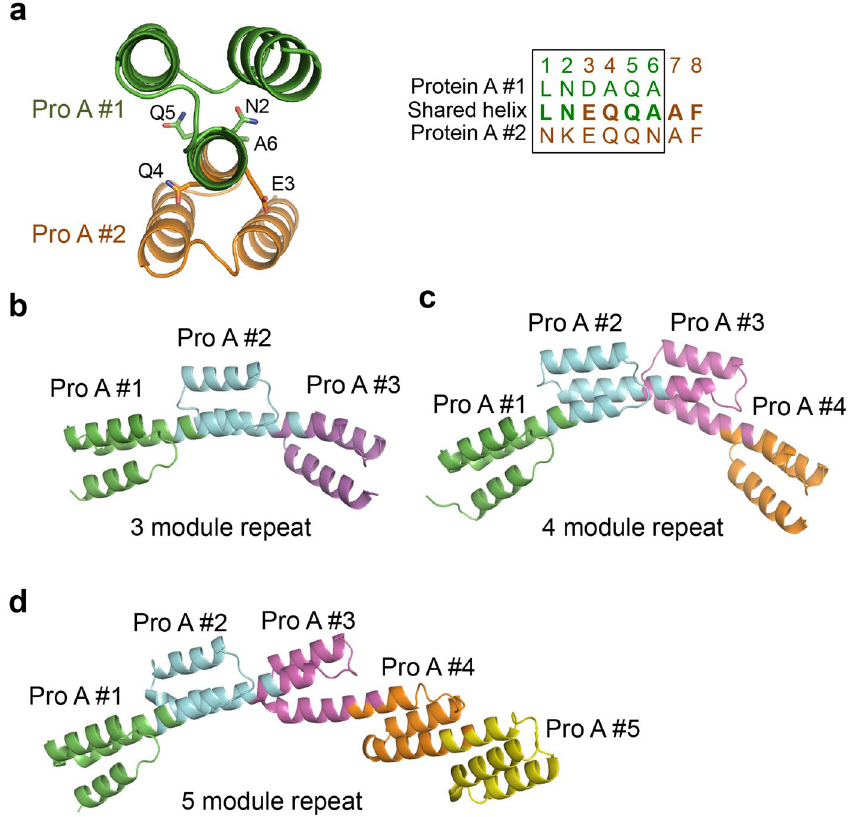
Figure 5. Construction of a repeat protein using the protein A domain as the repeat module. ( a ) Fusion strategy of protein A domains by the shared helix method. The amino acid sequences of the shared helix are shown on the right. The side chains of amino acids in the shared region are drawn as sticks. ( b ) The crystal structure of a repeat protein with three repeat modules. ( c ) The crystal structure of a repeat protein with four repeat modules. ( d ) The crystal structure of a repeat protein with five repeat